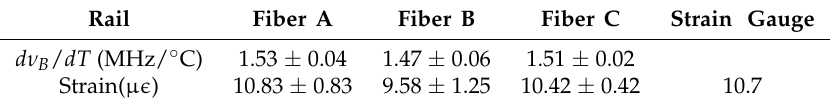
Table 2. Brillouin frequency-shift variation with the temperature of different fibers on the